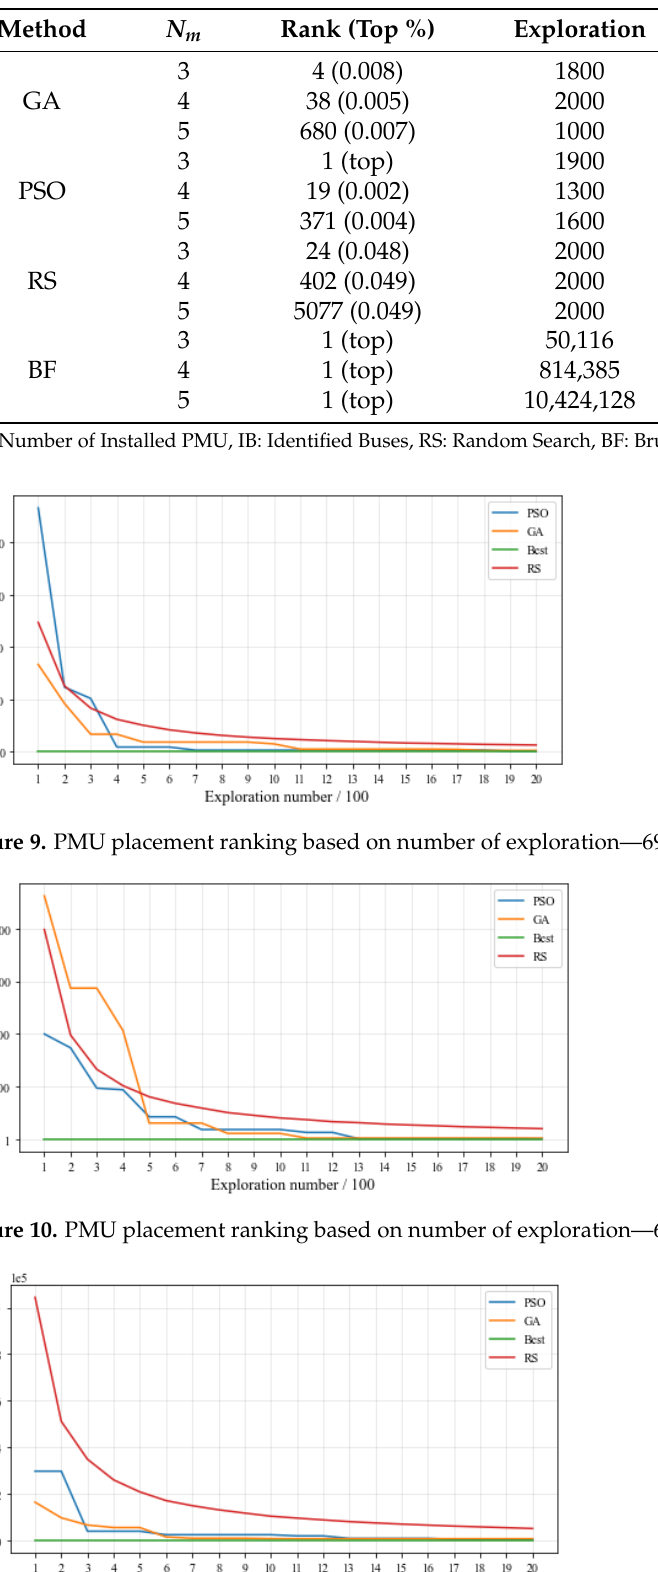
Table 4. PMU placement results—69-bus system.